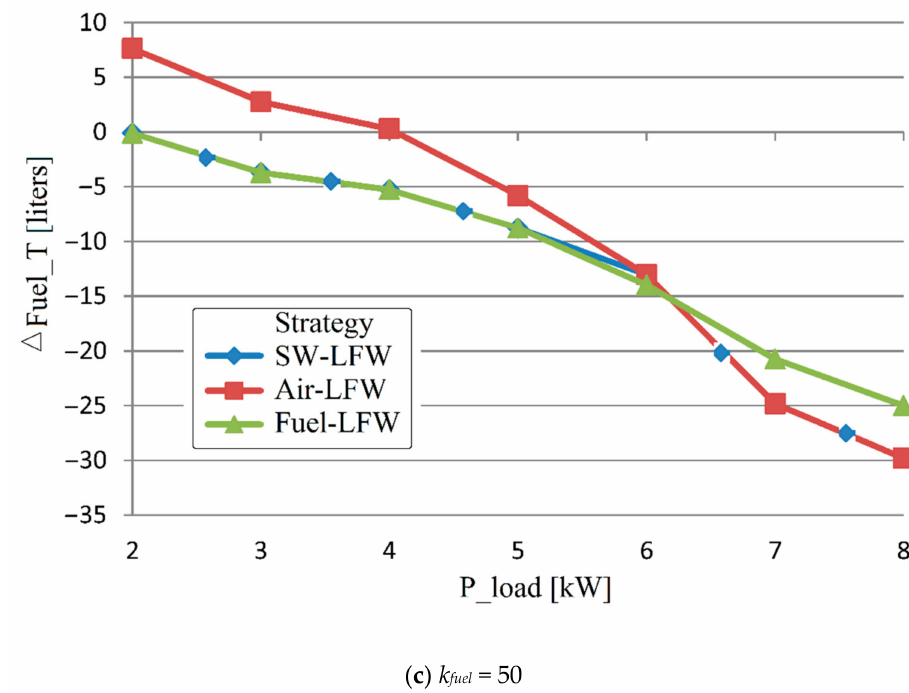
Figure 4. Fuel economy for constant